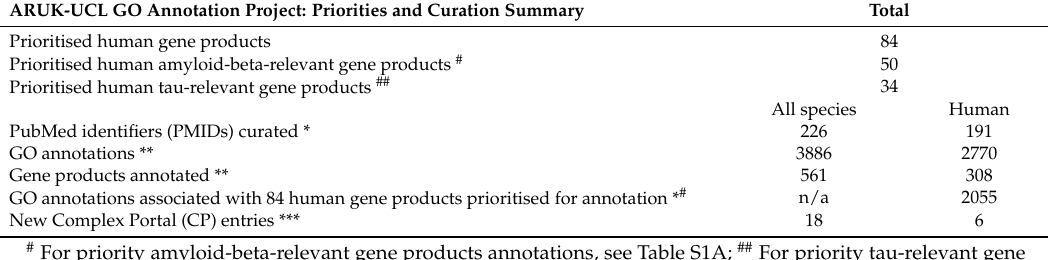
Table 1. Summary of key curation statistics. (Data from QuickGO [51–53] and the Complex Portal [14,63]—accessed: 18 October 2018—summarised in Supplementary Tables S1–S6). ARUK-UCL GO Annotation Project: Priorities and Curation Summary Total Prioritised human gene